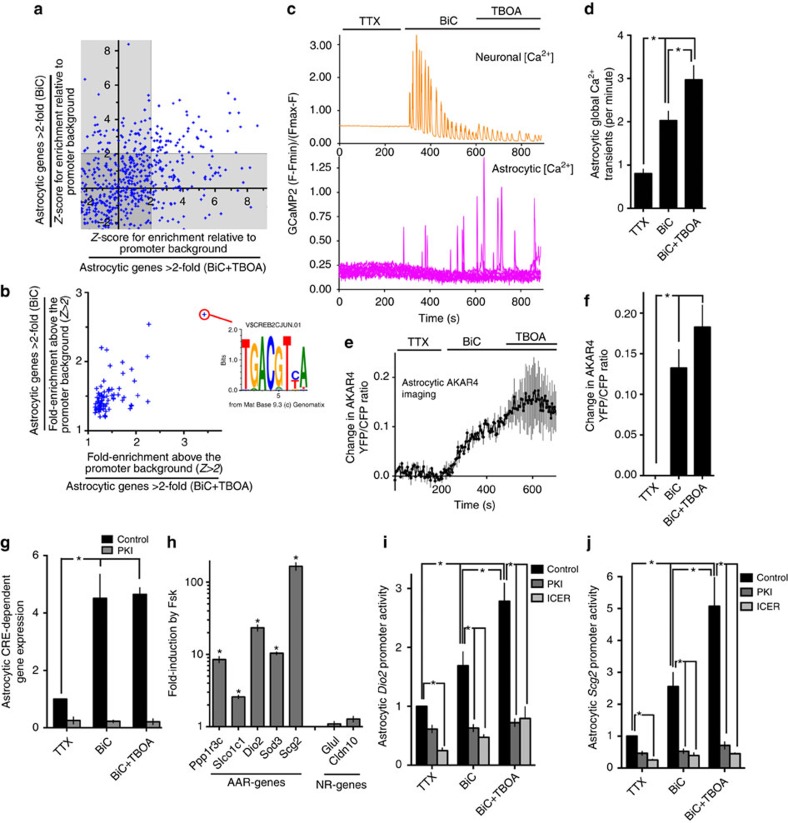
Astrocytic cAMP/PKA-dependent CREB activation contributes to activity-dependent astrocytic gene induction.(a,b) Promoters of astrocytic activity-responsive genes (induced more than twofold) were analysed within Genomatix for enrichment in TRANSFAC Library matrices, with the Z-score for enrichment calculated. Matrices enriched (Z>2) in the (overlapping) set of genes induced more than twofold by BiC and by BiC+TBOA are highlighted in a, and the degree of enrichment is shown in b, with the CREB family matrix highlighted (Supplementary Data 13). (c,d) Influence of neuronal activity induced by BiC (±TBOA) on astrocytic Ca2+ signals was measured. Left shows example traces of neuronal and astrocytic GCaMP2 imaging. Right shows influence of activity on astrocytic Ca2+ transient frequency. *P<0.05 (one-way analysis of variance (ANOVA) plus Tukey’s post hoc test, n=5, 32 cells total). (e,f) Influence of neuronal activity induced by BiC (±TBOA) on astrocytic PKA activity (PKA FRET probe AKAR4 transfected into astrocytes before neuronal co-culture. (e) shows an example experiment showing the mean (±s.e.m.) of several cells within a single field of view. (f) shows the quantitation. *P<0.05 (one-way ANOVA plus Tukey’s post hoc test, n=5, 15 cells). (g) Neuronal activity-induced PKA-dependent CRE-mediated gene expression in astrocytes. Mouse astrocytes were transfected with a CRE-luciferase reporter (plus renilla control,+globin control or PKI vectors) before rat neurons were overlaid for 9 days. Neuronal activity was induced by BiC (±TBOA) as described in Fig. 5a. Firefly luciferase activity was normalized to renilla transfection control. *P<0.05 (two-way ANOVA plus Sidak’s post hoc test, n=3). (h) Forskolin treatment is sufficient to induce astrocytic activity-response (AAR) genes. Mixed rat neuron/mouse astrocytes were treated with forskolin (Fsk, 10 μM, 4 h) and gene expression measured by qPCR using mouse-specific primers. *P<0.05 (two-way ANOVA plus Sidak’s post hoc test, n=3). (i,j) Activity-dependent induction of astrocytic Dio2 and Scg2 promoter activity is mediated by PKA and CREB. Mouse astrocytes were transfected with a Dio2 (i) or Scg2 (j) -luciferase reporter (plus renilla control,+control, PKI, or ICER vectors) before rat neurons were overlaid for 9 days. Neuronal activity was induced as described in Fig. 5a. Firefly luciferase activity was normalized to renilla control. *P<0.05 (two-way ANOVA plus Sidak’s post hoc test, n=3). All error bars represent s.e.m.